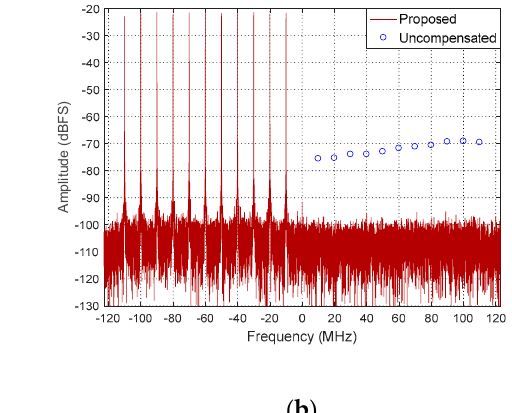
Figure 12. The amplitude spectra of multi ‐ tone signal: ( a ) before imbalance compensation; ( b ) after imbalance compensation. The number of calibration points N = 64 and the number of signal points 2N 1 = 56.